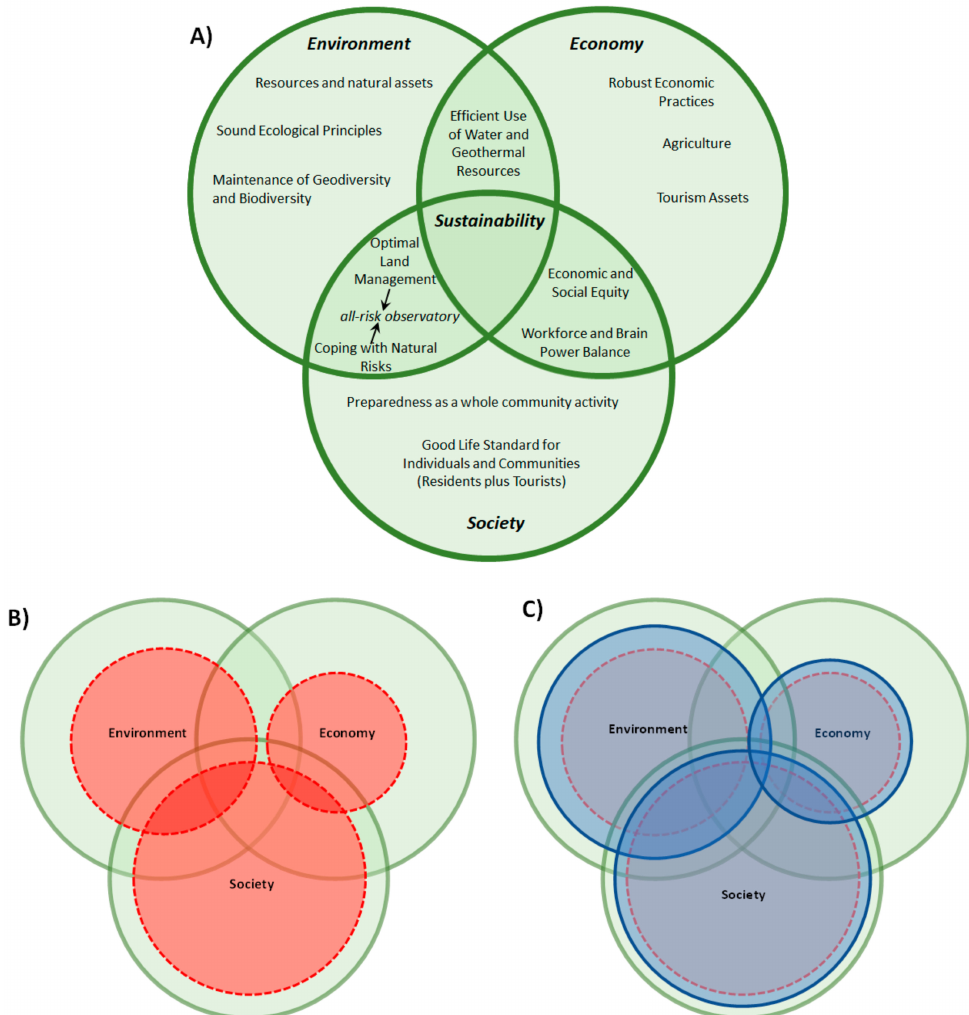
Figure 11. ( A ) The sustainability tripod made resilient, modified from Gary et al. (2005) [112]. The sustainable tripod time can shrink differentially for the three compartments right after a sudden shock such as a volcanic eruption occurring on small and relatively territories, such as SIDS. ( B ) applies conceptually to a low-resilient or even anti-resilient SIDS system, with the shock making the sustain- able set of conditions to disappear. Lack of preparedness appears as a major factor. ( C ) refers instead to a SIDS system which has implemented policies for preparedness and recovery discussed in the text and which allow quick and sustainable